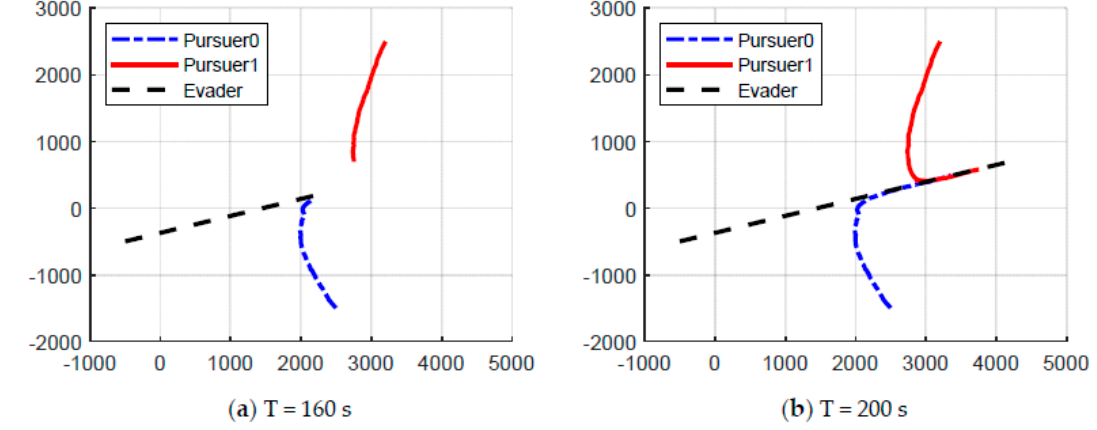
Figure 11. The traces of P 0 , P 1 and E 0 under knowledge control with ∆ v = 30% v P .